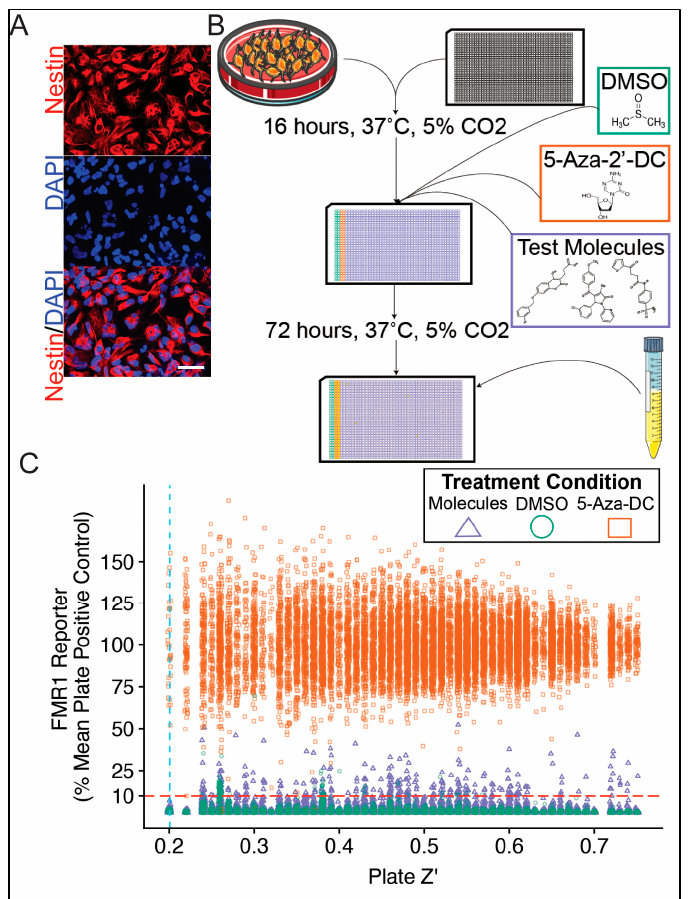
Figure 2. Primary screen for small molecules capable of reactivating FMR1 in human neural stem cells. Neural progenitor cells (NPCs) were differentiated from human FXS iPSC reporter line. Micrograph of reporter NPCs demonstrates characteristic morphology and expression of Nestin via immunofluorescence ( A ). A high-throughput small molecule screening assay was designed and optimized to test FMR1 reporter activity in neural progenitor cells (NPCs) ( B ). NPCs were treated with either test compound (320,587 unique compounds, 12.5 µM), 5-aza-2 ′ -deoxycytidine (5-Aza-DC, positive control), or DMSO (vehicle) for 72 h prior to being assayed. The results of the entire primary screen are plotted displaying test plate Z’ on the x -axis against individual test molecule response on the y -axis ( C ). Molecules were considered as candidates for secondary screening if they exceeded a plate Z’ threshold of 0.20 (blue dashed vertical line) and an individual response threshold of 10% mean plate 5-Aza-DC response (red dashed horizontal line). Scale bar = 50 μ m.